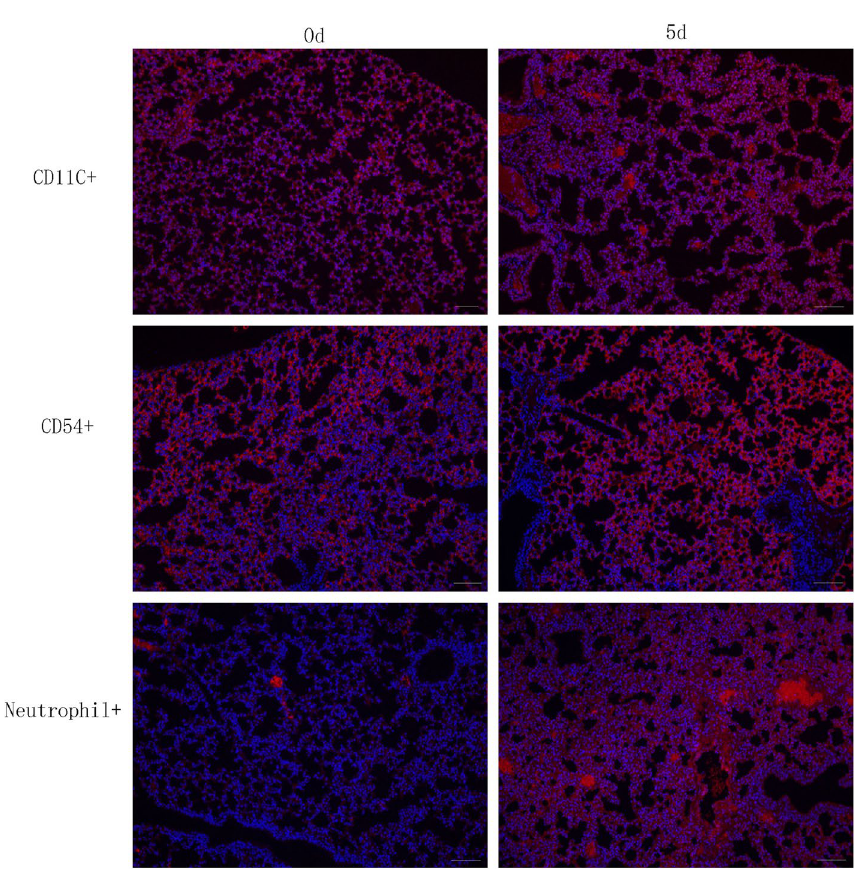
Figure 4. The recruitment of immune cells in the lungs in mice intravenously infected with Cladosporium cladosporioides. Numerous polymorphonuclear neutrophils (neutrophil + ), macrophages, and dendritic cells (CD11C + ) were recruited in the lung tissue in mice intravenously infected with Cladosporium cladosporioides , along with marked CD54 expression (CD54 + ) (red fluorescence increased). Data are representative of three independent experiments (n = 4 mice per group). Scale bars, 200